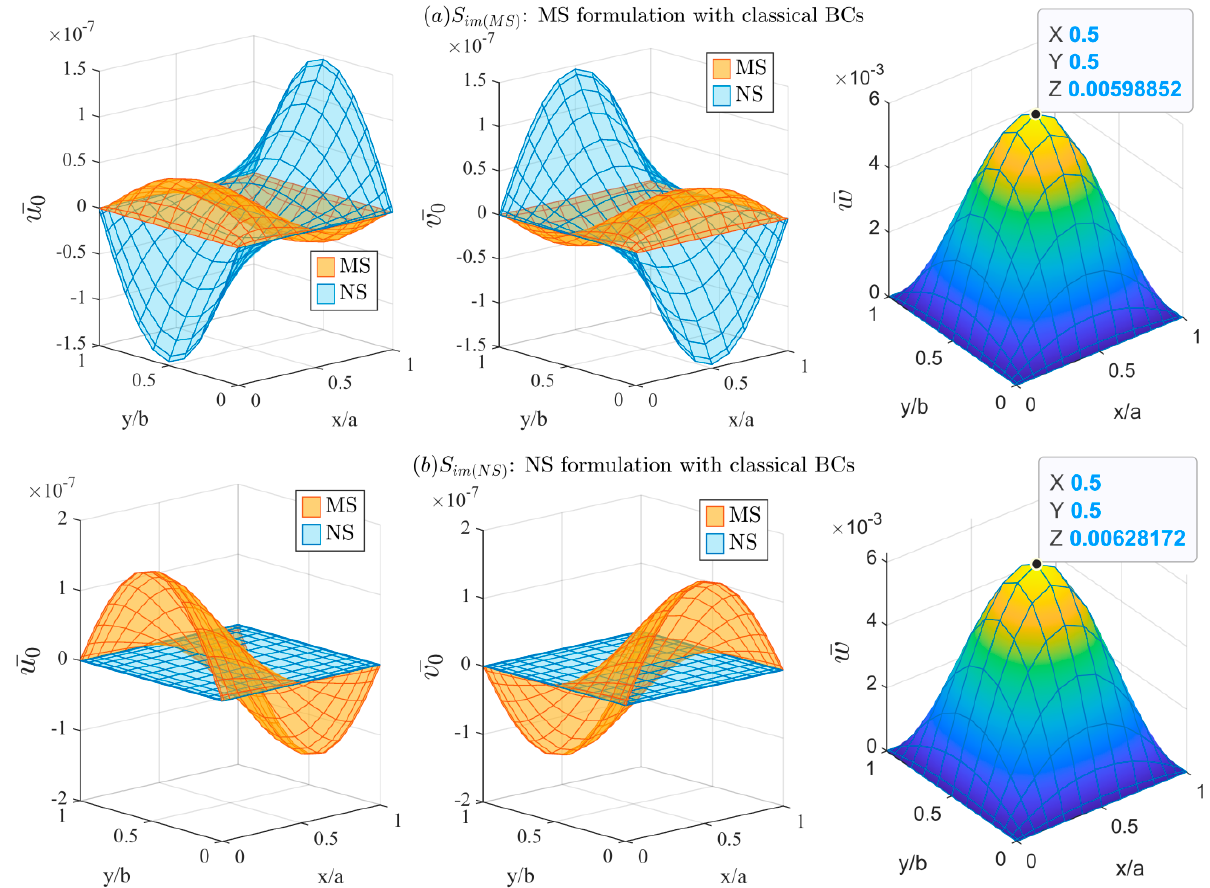
Figure 7. Solutions generated by ( a ) MS and ( b ) NS formulations by the classical BCs (Equation (20))